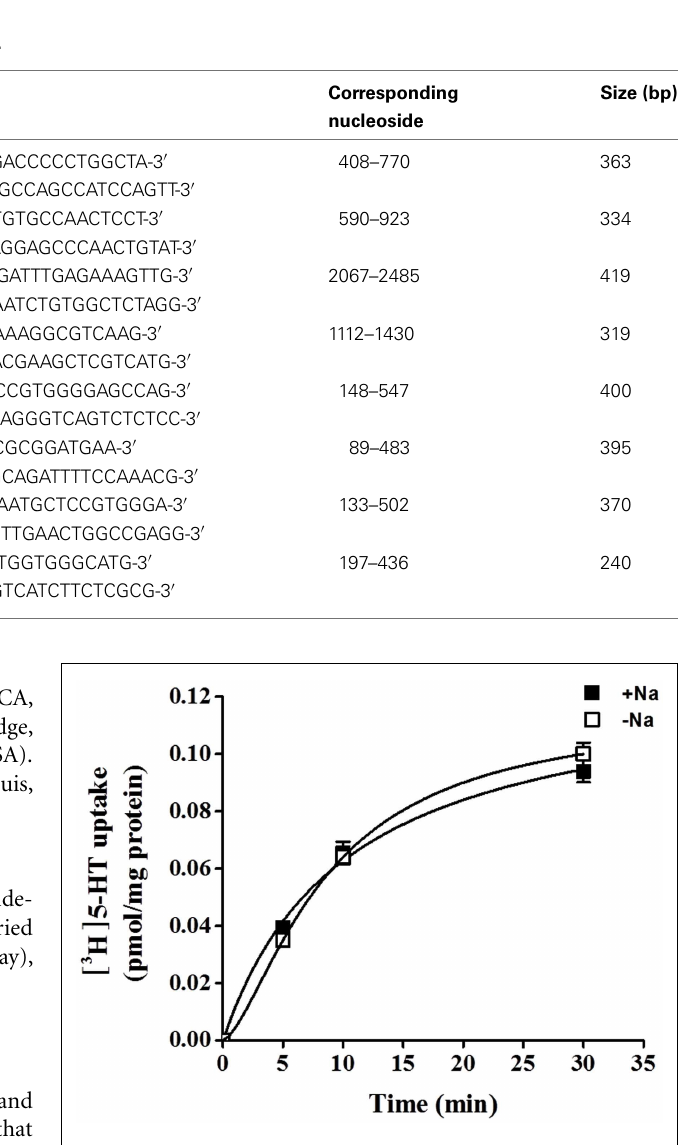
10.49 ± 5.98, and 2.80 ± 1.04 µ M, respectively ( Figure 3 ).